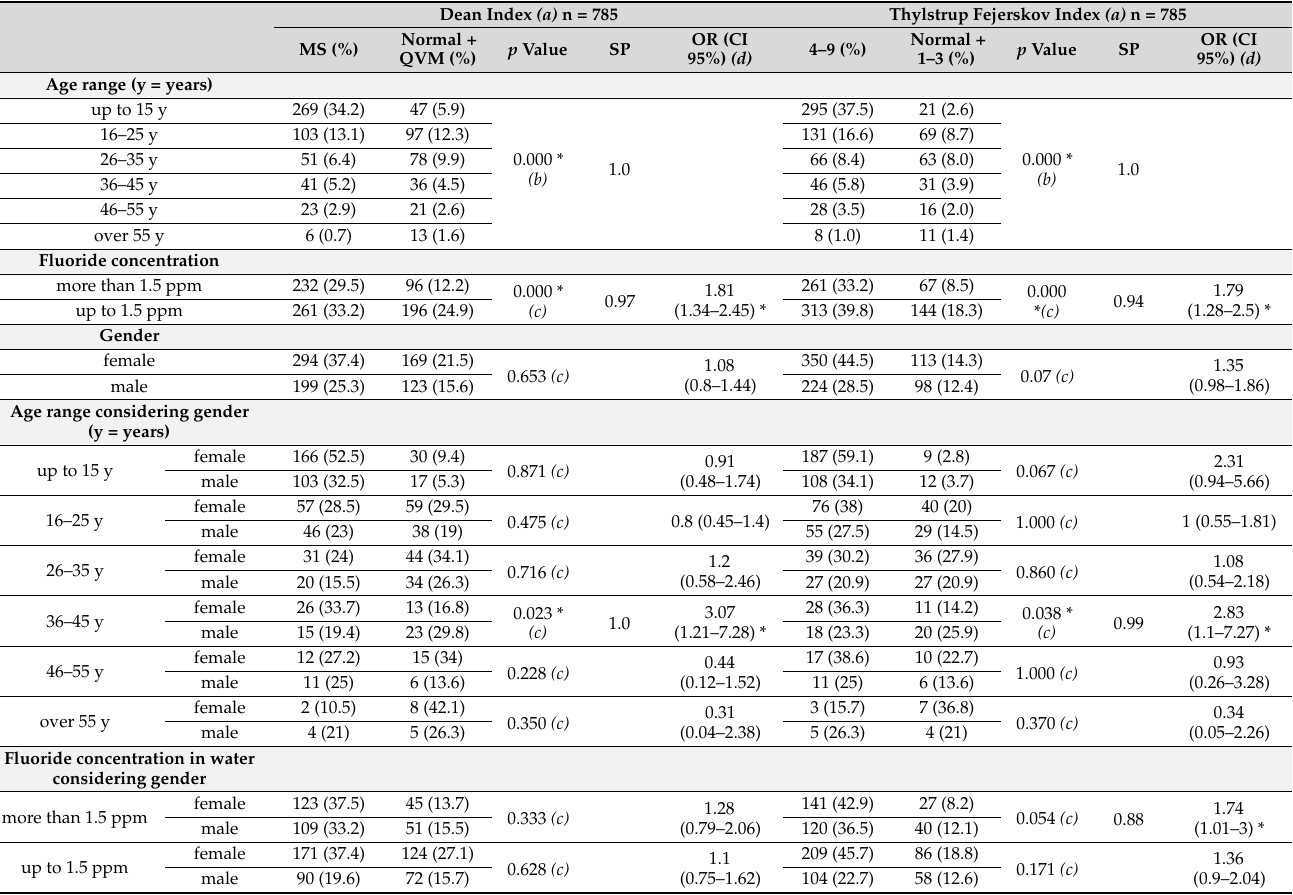
Table 2. Analysis of fluorosis distribution considering gender, age range, and fluoride concentration in water